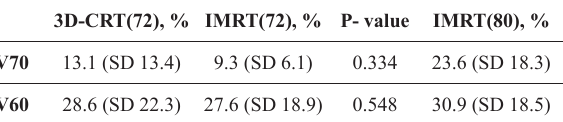
Table 3: Mean % V60 and V70 values of bladder in IMRT and 3D-CRT.